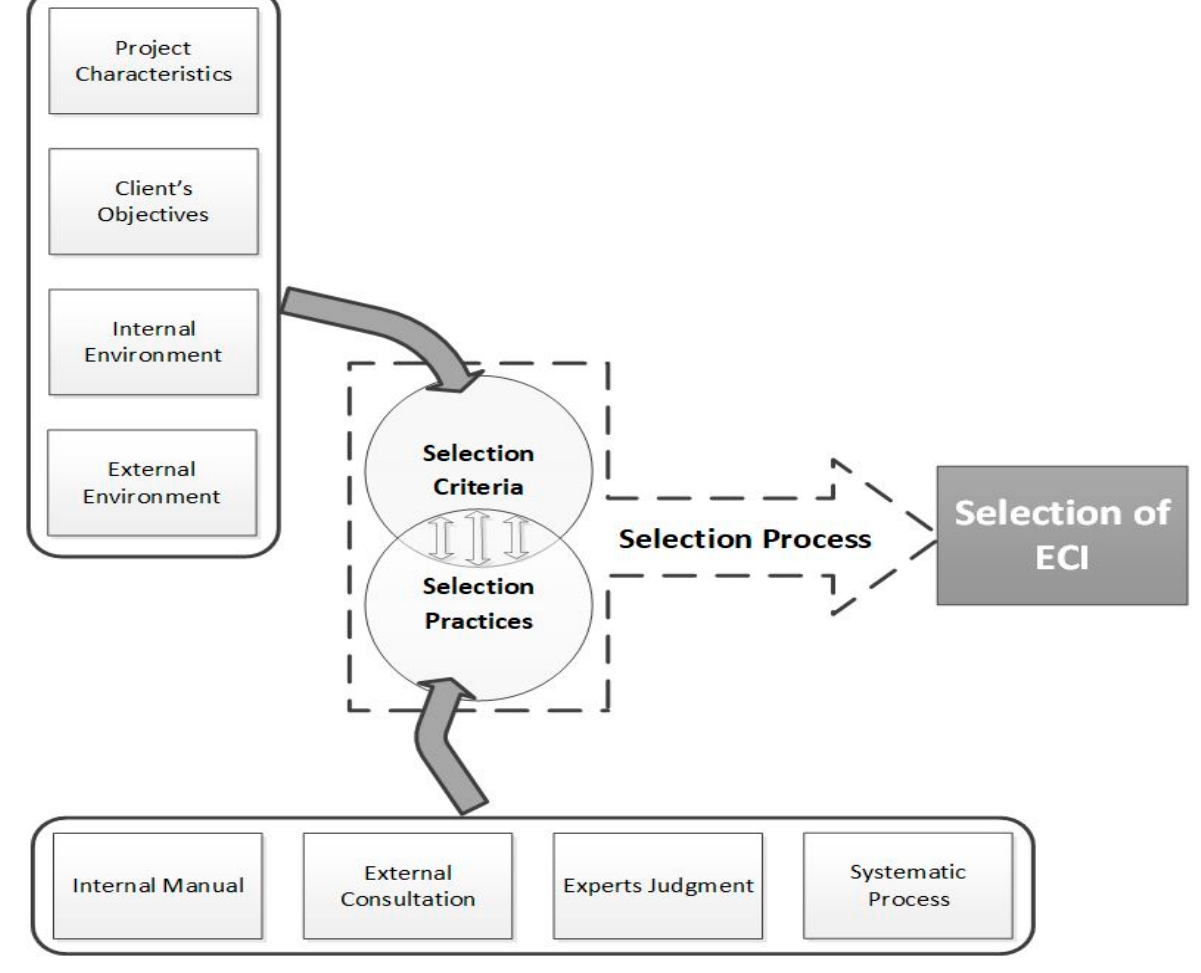
Figure 2. Conceptual model for selection of ECI (client perspective) .